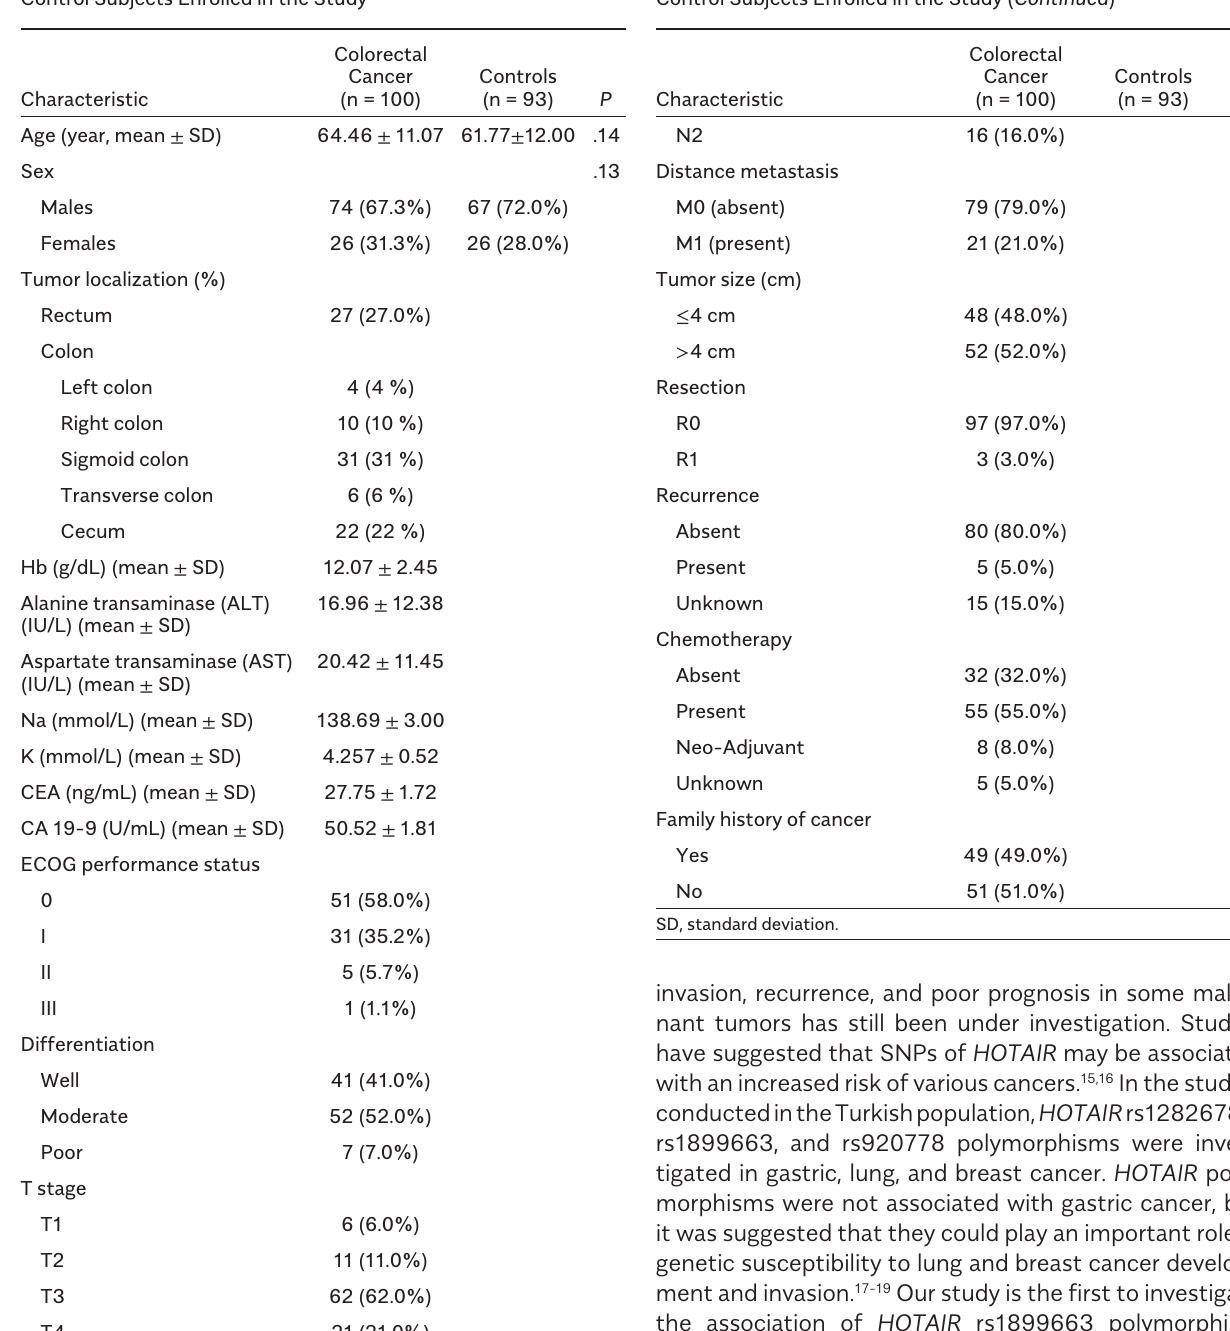
Table 1. Clinical Characteristics of Colorectal Cancer Cases and Control Subjects Enrolled in the Study